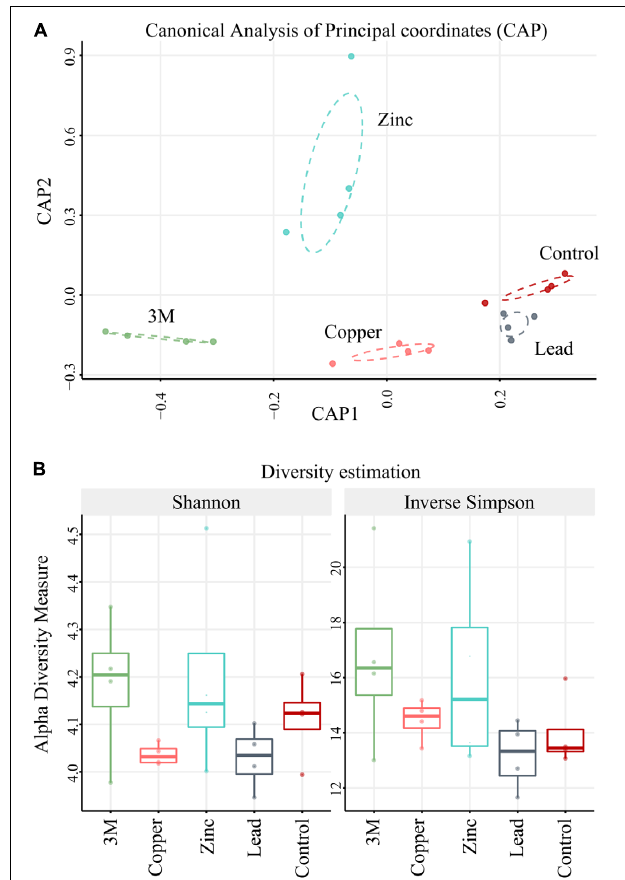
FIGURE 2 | CAP and diversity. (A) Ordination plot using Canonical Analysis of Principal coordinates model (CAP) based on Bray–Curtis distances. (B) Compared alpha-diversity box plots for each treatment and control based on two diversity estimators: Shannon and Inverse Simpson indices. n = 4 replicate blocks per